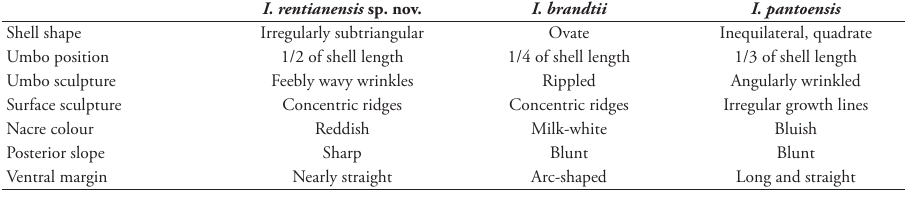
Table 2. Conchological characters of Inversidens rentianensis sp. nov., Inversidens brandtii , Inversidens pantoensis . Characteristic descriptions of I. brandtii and I. pantoensis are referenced from Kondo (1982, 2008) and He and Zhuang (2013).